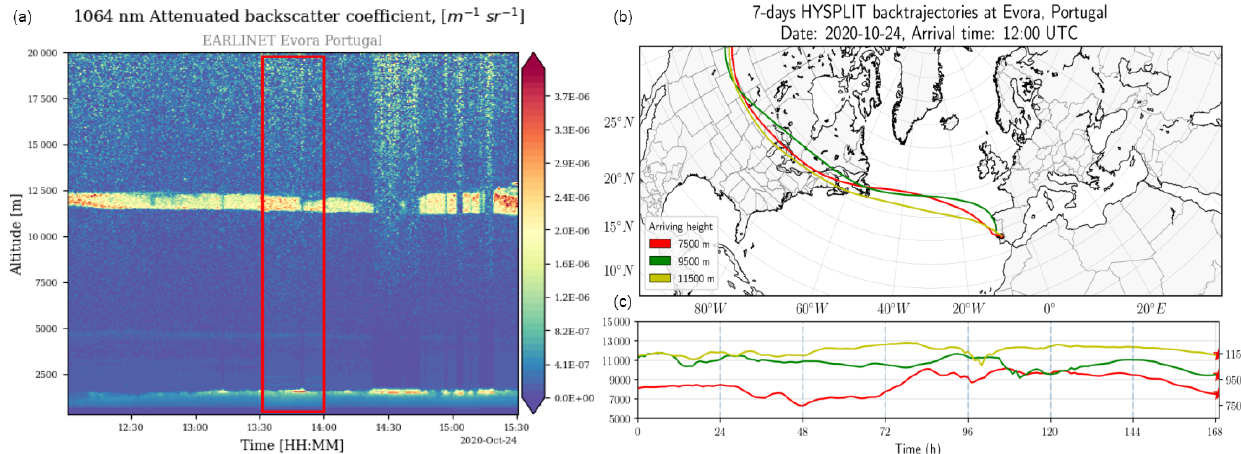
Figure 10. (a) Temporal evolution of the total attenuated backscatter signal from the PAOLI Polly XT lidar system at 1064nm showing the detection of the smoke cloud, and (b) 7d HYSPLIT back trajectories arriving at Évora, Portugal on 24 October 2020 at 12:00UTC.